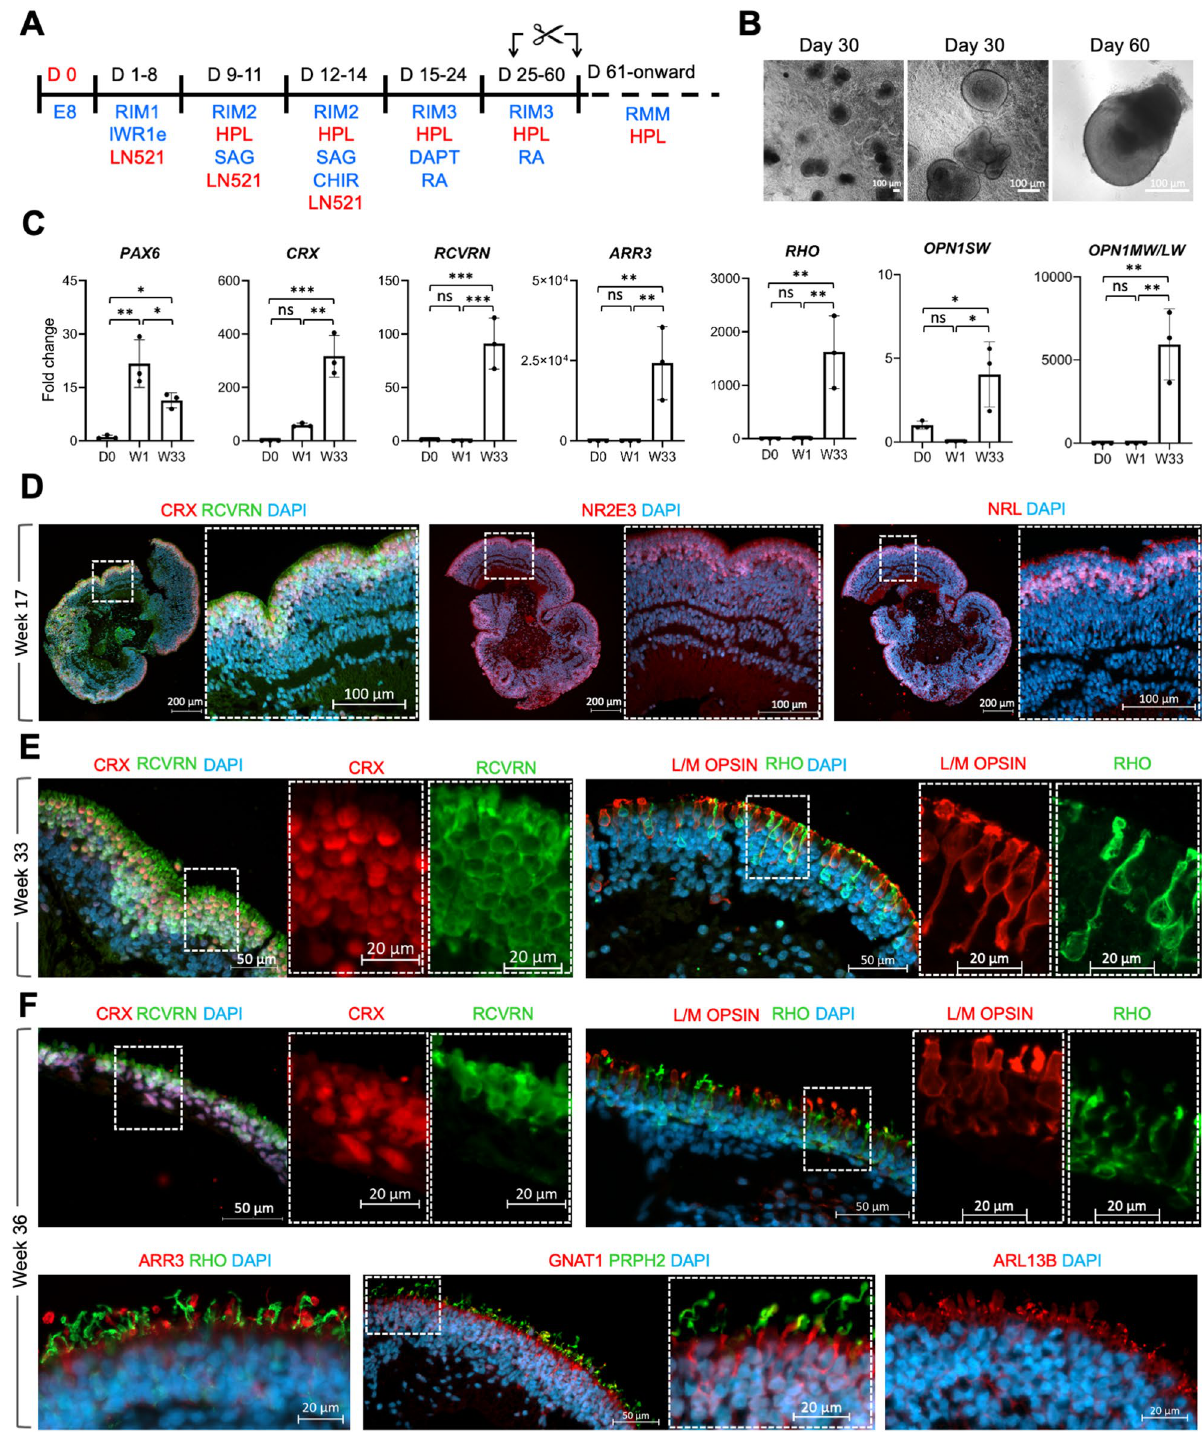
Figure 2. Small molecule-based 2D/3D differentiation of hPSC into retinal organoids under xeno-free condition. ( A ) Schematic of the 2D/3D xeno-free small molecule protocol ( B ) Bright-field microscopy of 3D optic vesicle-like structure at day 30 and manually picked organoid at day 60 of differentiation (scale bars 100 µm) ( C ) RT PCR analysis of relative expression of retinal marker genes (mean ± SD; n = 3 independently cultured sets of 10 OVs from N = 1 ESC line, MShef10). ( D ) Immunohistological analysis of retinal organoids at week 17 of differentiation (generated from MShef10 ESC line; scale bars 100 µm). ( E ) Immunohistological analysis of CRX, RCVRN, OPN1MW/LW, and RHO in retinal organoids at week 33 of differentiation (generated from MShef10 ESC line). ( F ) Immunohistological analysis of CRX, RCVRN, OPN1MW/LW, ARR3, RHO, GNAT, PRPH2, ARL13B in retinal organoids (from MShef10 ESC line) at week 36 of